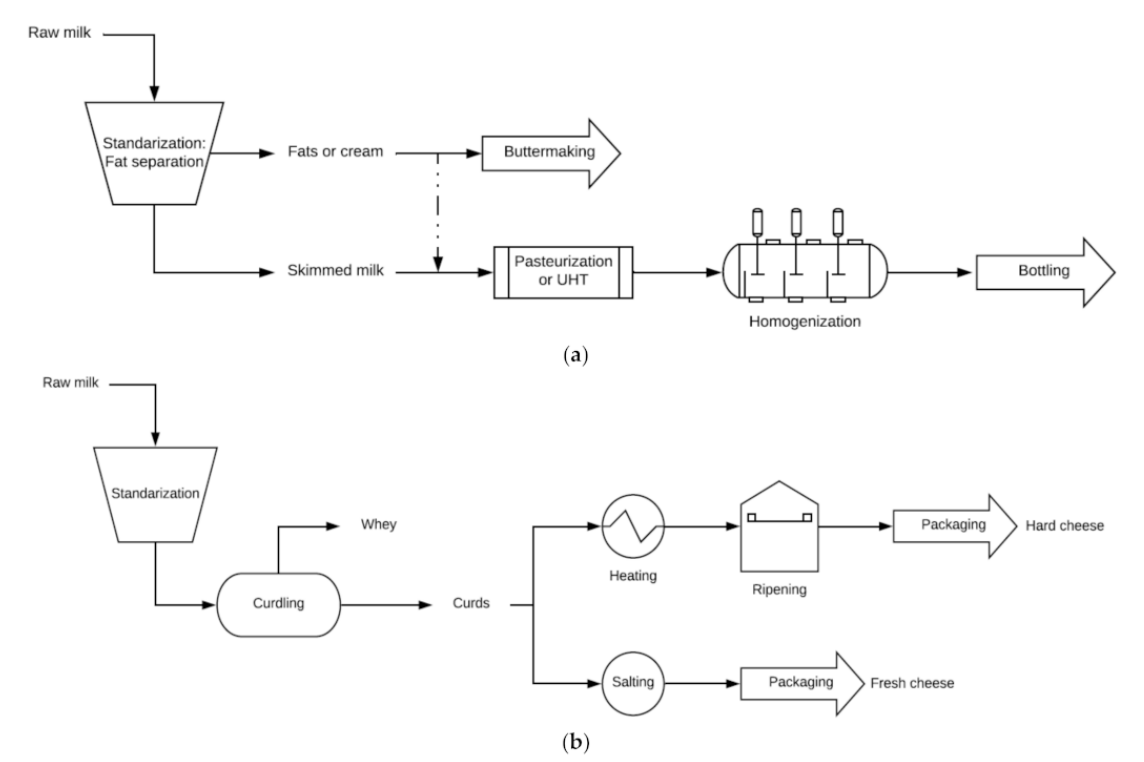
Figure 2. Traditional process schemes for ( a ) milk and ( b ) cheese